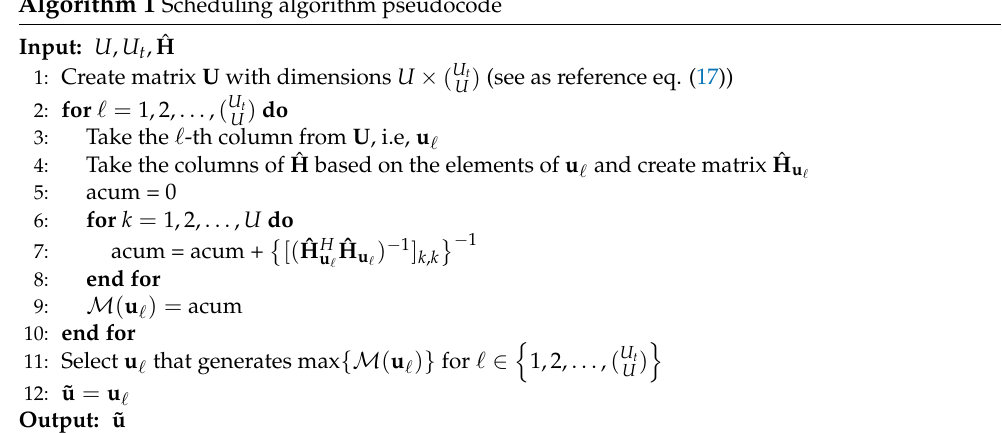
Algorithm 1 Scheduling algorithm